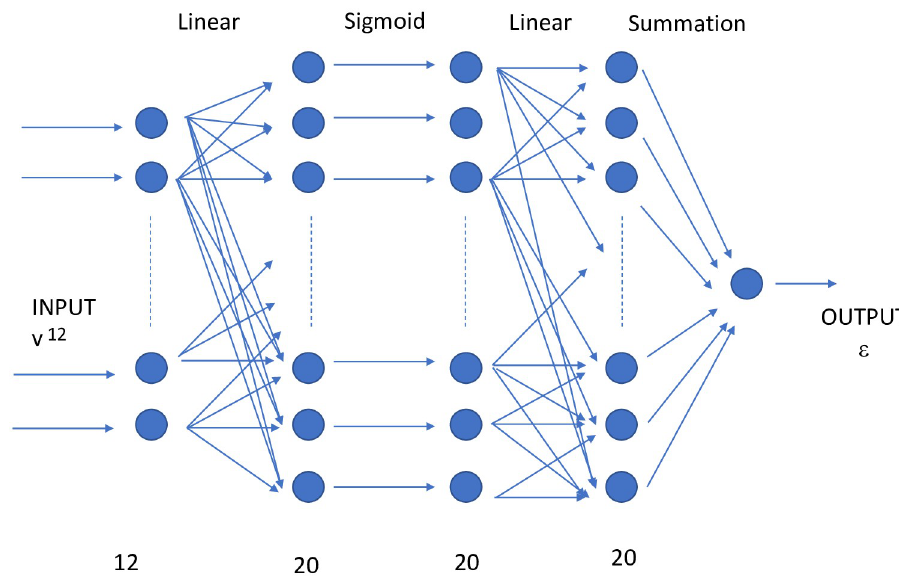
Fig 2. The structure of the neural network used in the